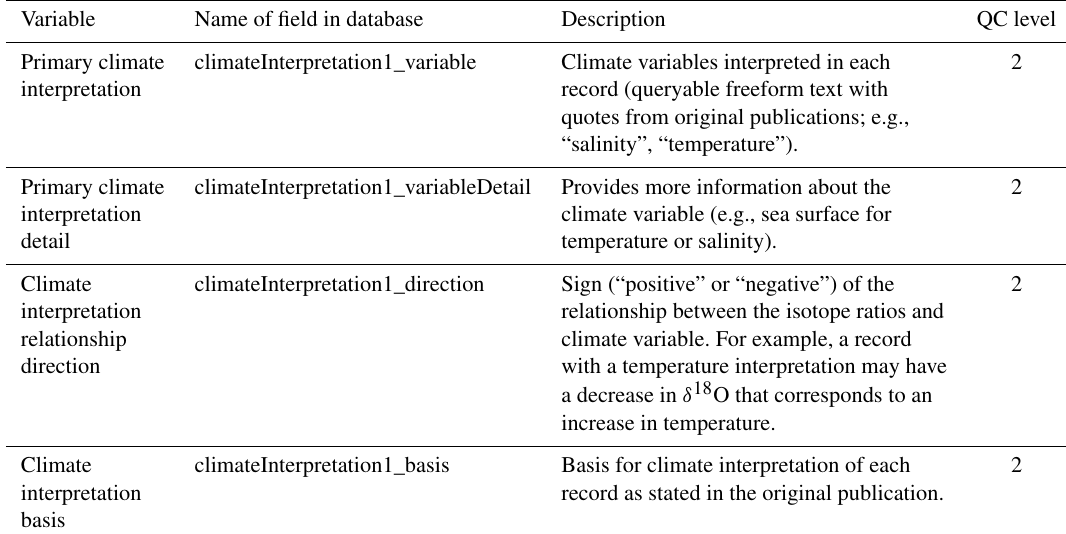
Table 4. Key climate interpretation metadata.